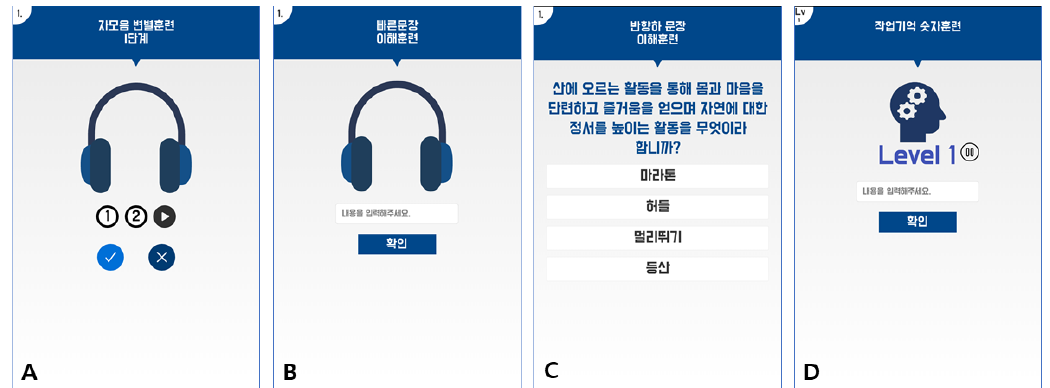
Figure 2. Image examples of the developed HeRO healthcare mobile application for four types of auditory training in the present study: ( A ) syllable training, ( B ) sentence training, ( C ) discourse training and ( D ) working memory.